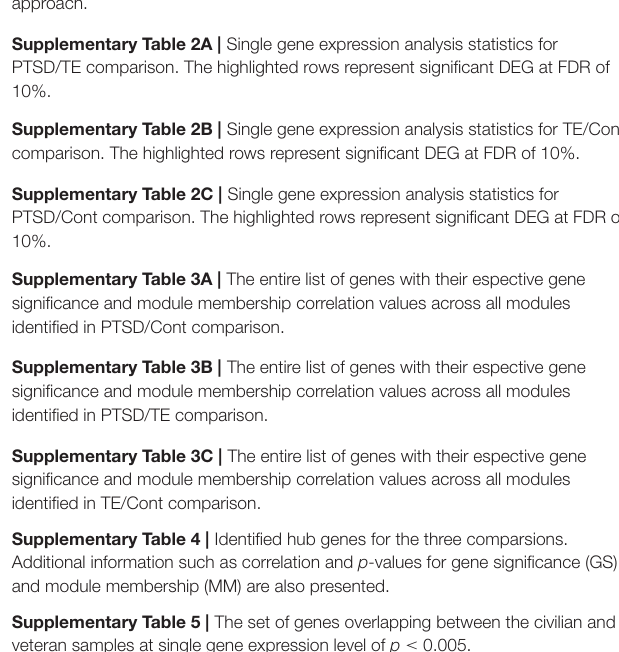
Supplementary Table 1 | Microarray validation using quantitative (qPCR) approach.